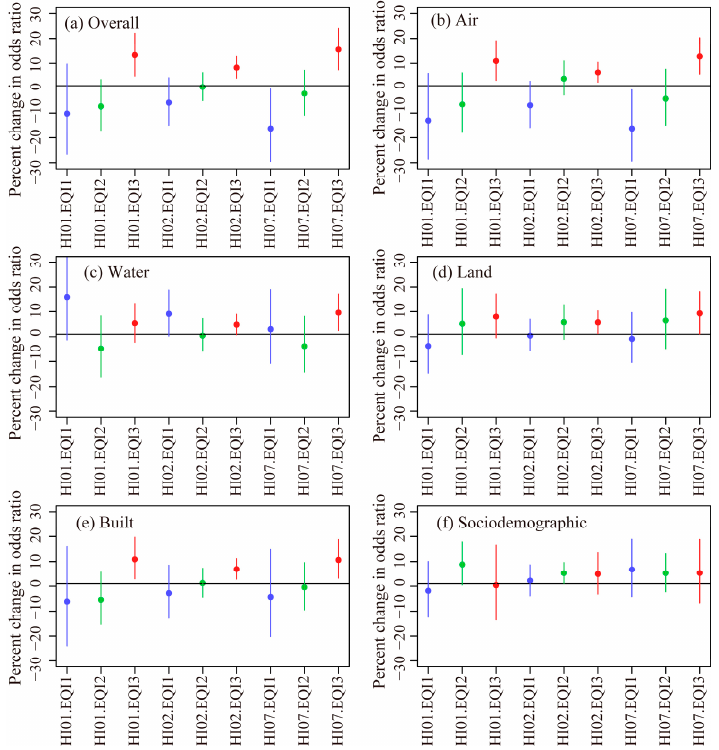
Figure 2. Percent change in odds ratio comparing heatwave days (HI01, HI02, and HI07) and non-heatwave days by tertiles of overall EQI and EQI domain indices, in metropolitan counties in Alabama. A higher EQI tertile represents a worse environmental quality.